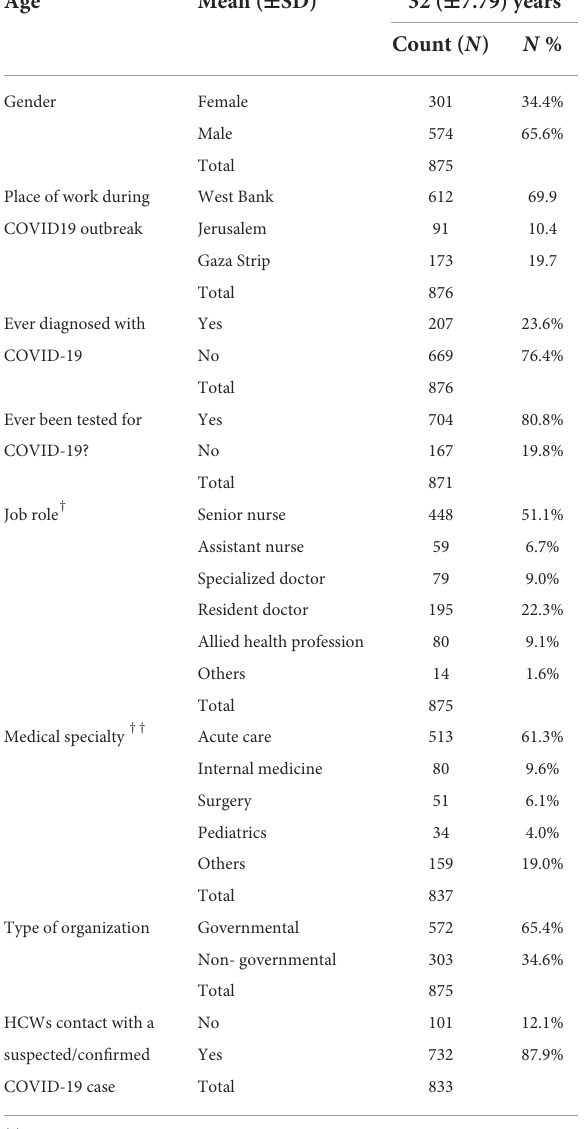
TABLE 1 Characteristics of study